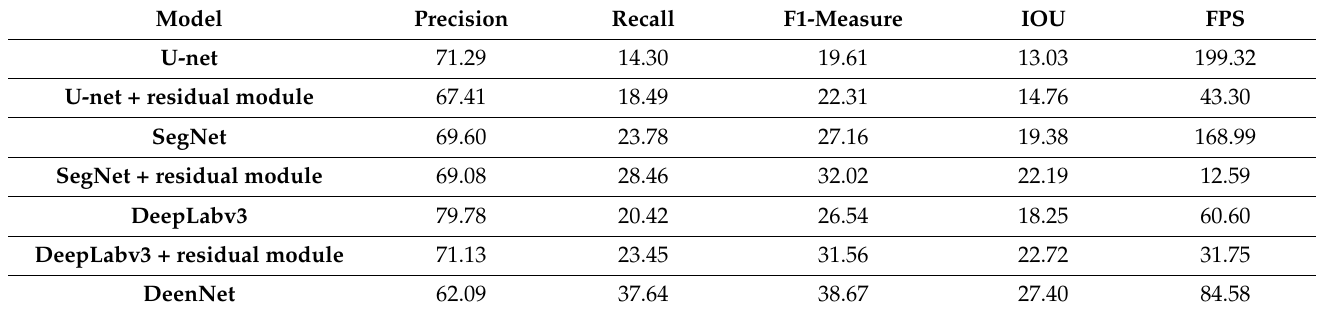
Table 3. Statistics used to assess the performance of the models in terms of landslide detection on the Bijie landslide dataset (%).